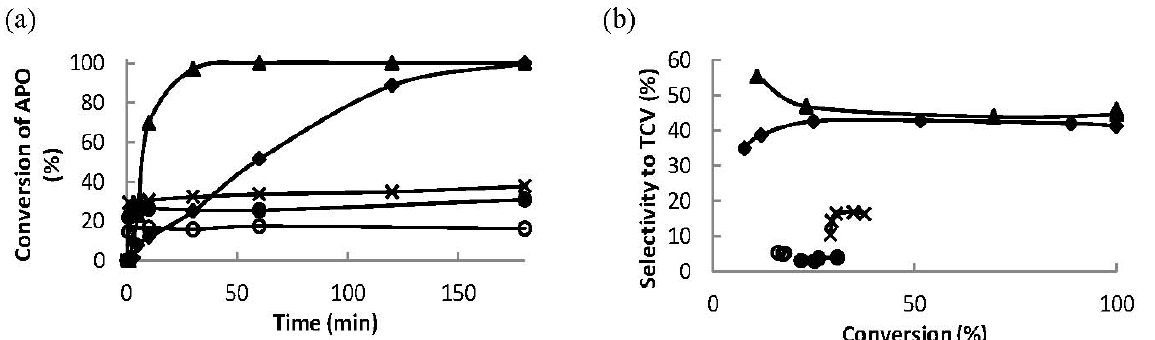
Figure 8. ( a ) Conversion of α -pinene oxide as a function of reaction time and